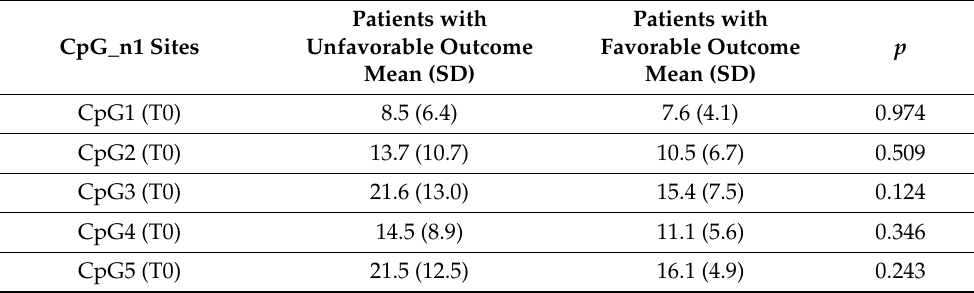
Table 2. Methylation percentage comparison of the CpG_n1 island sites (CpG1, CpG2, CpG3, CpG4, CpG5) at baseline (T0), after rehabilitation treatment (T1) and their changes from baseline ( ∆ ) in patients with or without a favorable outcome (BI ≥ 75 at discharge). p values refer to the Mann–Whitney U test.